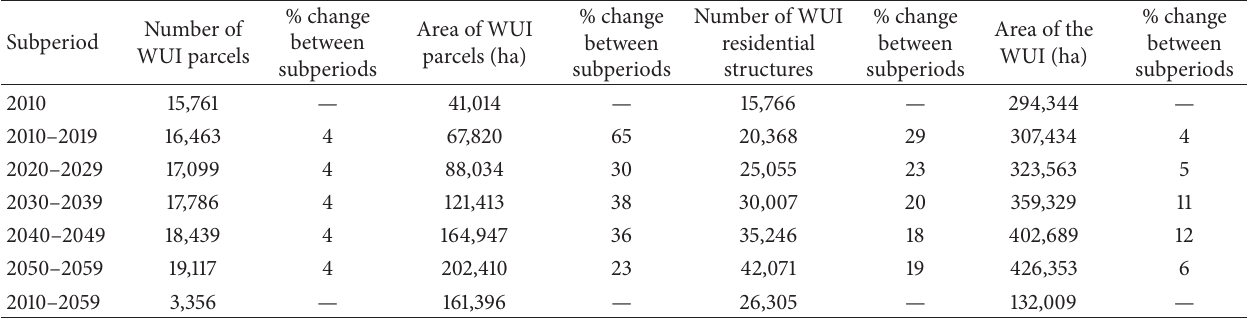
Table 2: Simulated number of WUI parcels, area of WUI parcels, number of WUI residential structures, and area of the WUI for Flathead County, 2010 and five